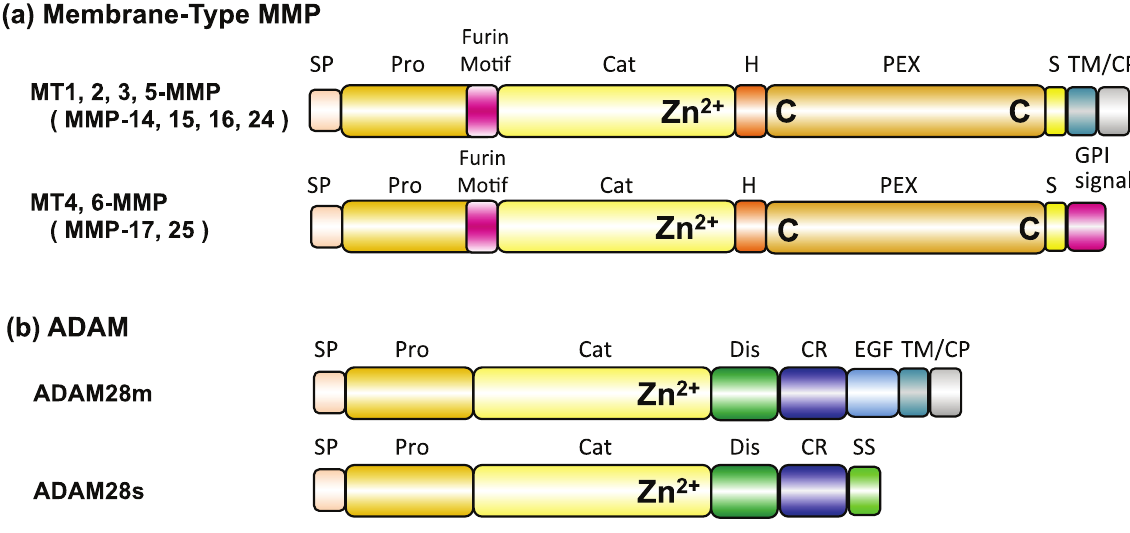
Figure 6. Domain structures of MT-MMPs ( a ) and ADAMs ( b